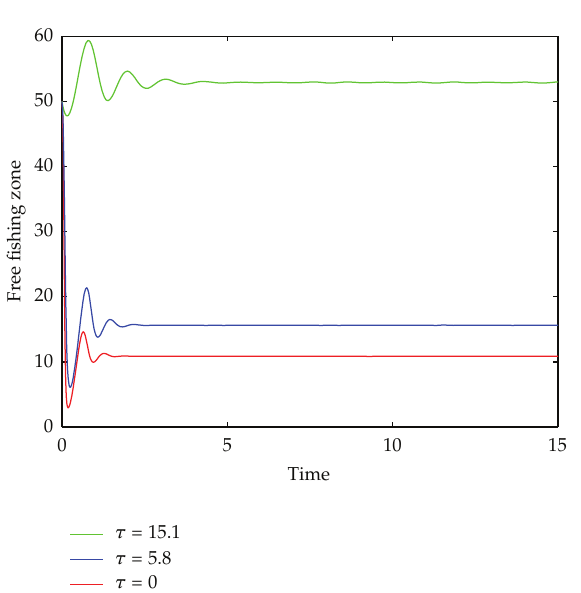
Figure 3: Variation of free fishing zone population with time for di ff erent tax levels.